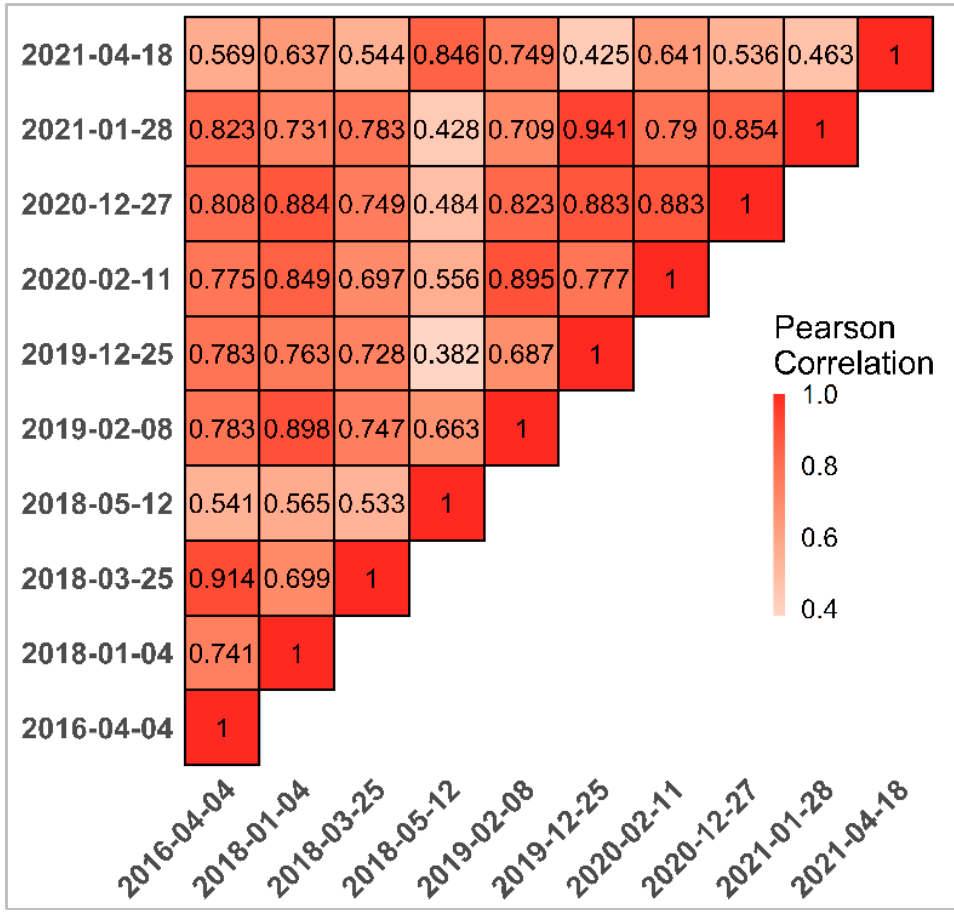
Figure 5. Heat map of the person correlation between pairs.